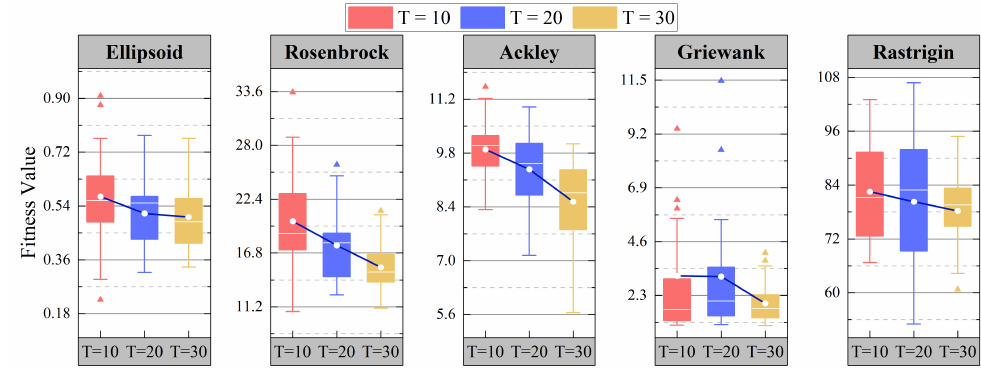
Figure 6. The fitness of five benchmarks with 10/20/30